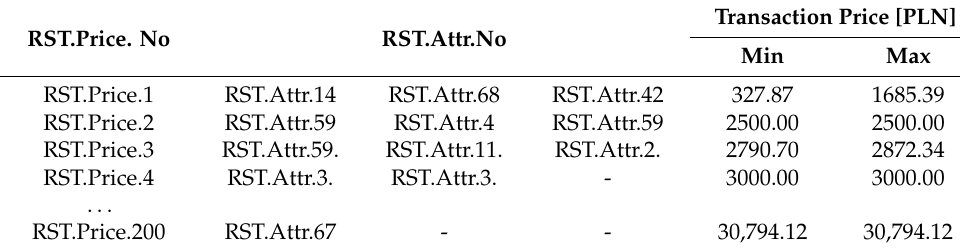
Table 5. Example of matching RST.Attr. groupings of homogeneous property attributes with the RST.Price. homogeneous price groupings within a selected homogeneous area. Source: own